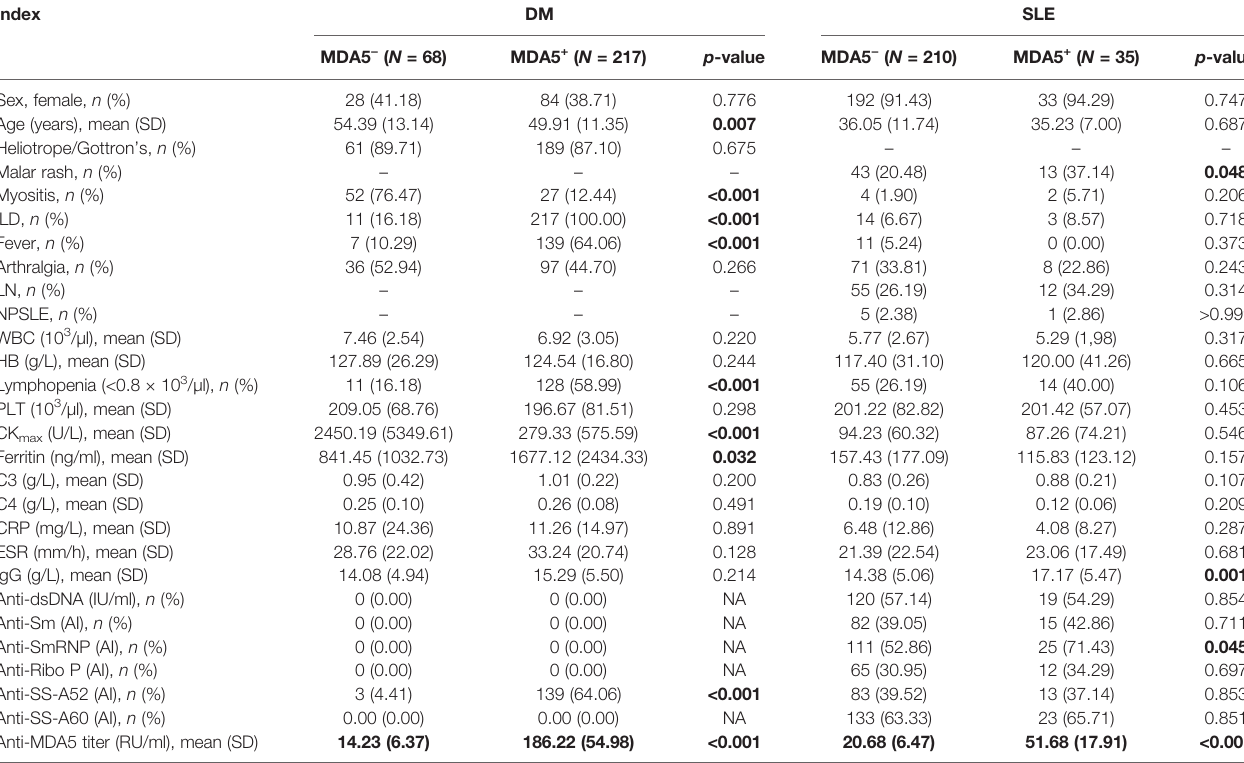
TABLE 1 | Clinical and serological characteristics among patients with anti-MDA5 +/ − dermatomyositis (DM) and systemic lupus erythematosus (SLE). Index